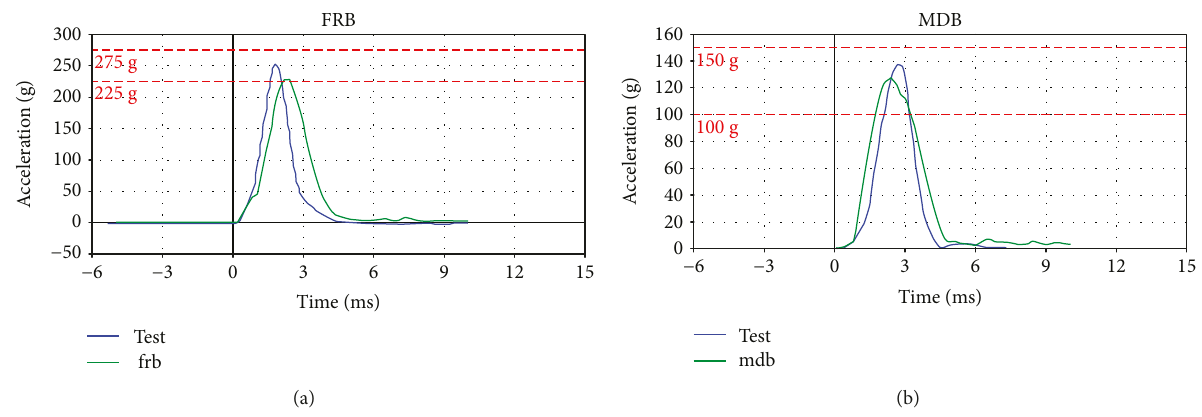
Figure 9: The acceleration-time curves of the dummy head model under frontal and lateral Table 2: Comparison of two peak accelerations between simpli fi ed Table 3: 16 groups obtained by DOE and its corresponding head model and physical dummy head. response.